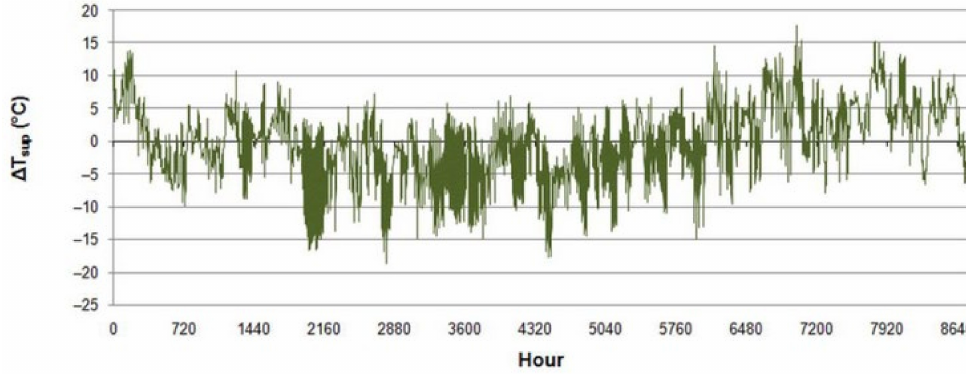
Figure 16. The change in the temperature of the air flowing through the exchanger over a year (0 h = 1 January, 8760 h = 31 December) [100].